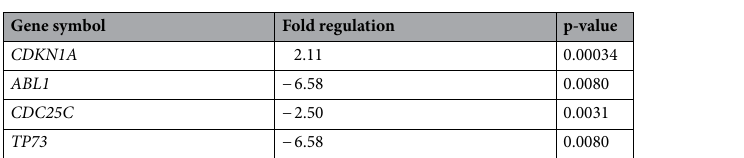
Table 1. List of significantly (> 2 folds) upregulated or downregulated genes in whole-cell-irradiated compared with nucleus-irradiated (1 Gy) WI-38 cells from three independent experiments. Each comparison is performed using pairs of samples from the same batch. p-values are calculated using a Student’s t test.